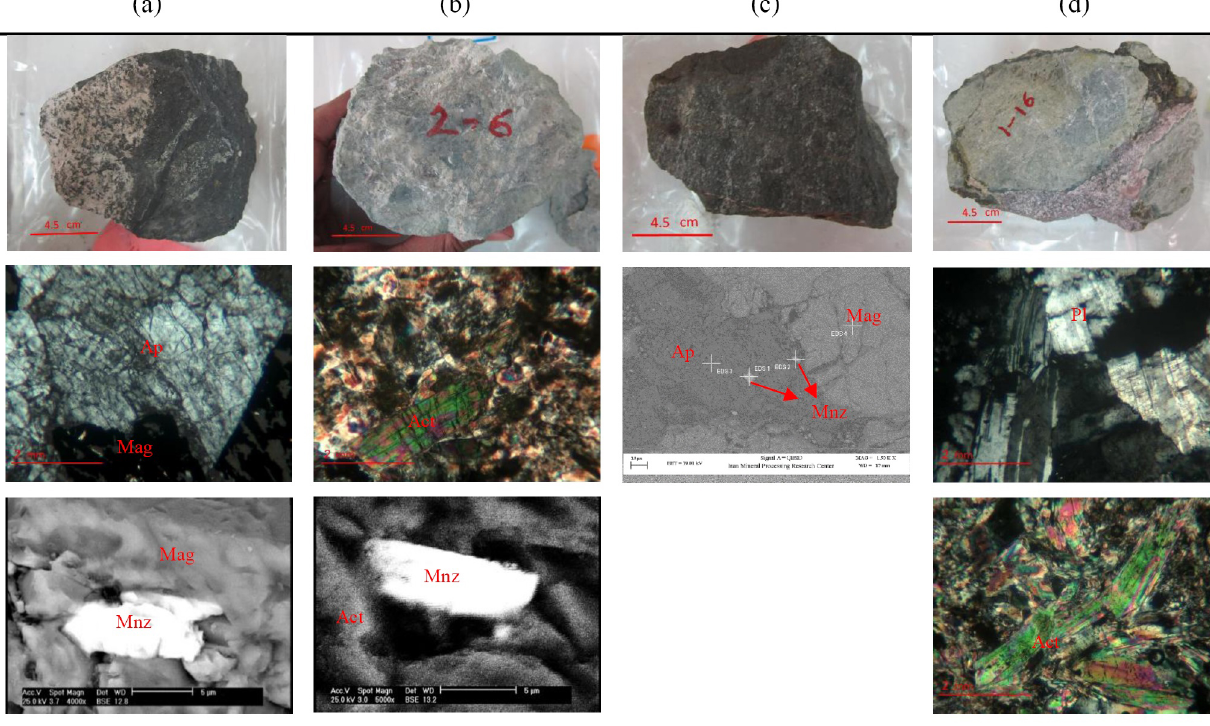
Figure 7. Some examples for samples which have been classified in four types along with their microscopic images. (a) Type 1: high anomaly (phosphorus iron ore), sample 4–1, iron ore sample including apatite and monazite; (b) type 2: low anomaly (metasomatized tuffs), sample 2–6, including actinolite, calcite, feldspar and monazite; (c) type 3, low anomaly (iron ore), sample 4–6, iron ore sample including apatite (mostly depleted from REEs) and monazite; (d) type 4: background (iron ore and others), sample 1–16, metasomatite including plagioclase, feldspar and actinolite. Abbreviations: Ap – apatite; Mnz – monazite; Act – actinolite; Mag – magnetite; and Pl –